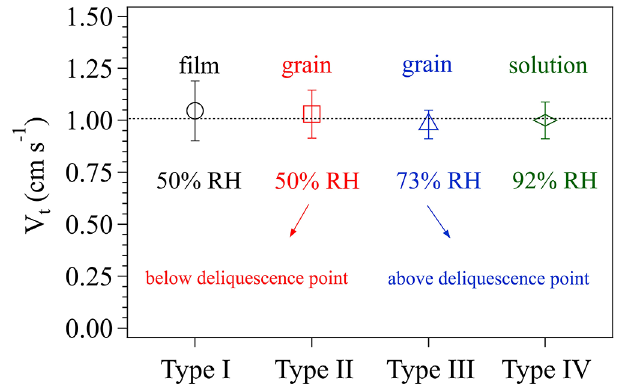
Figure 6. The effects of different surface phase states of KI coat- ings on the transport-limited deposition velocity V t . The four types of KI coatings are indicated on the x axis, and details of the coating preparation can be referred to in the text. The RH values represent the relative humidity conditions of the air in the chamber. The er- ror bars represent the standard deviation of three to four replicate